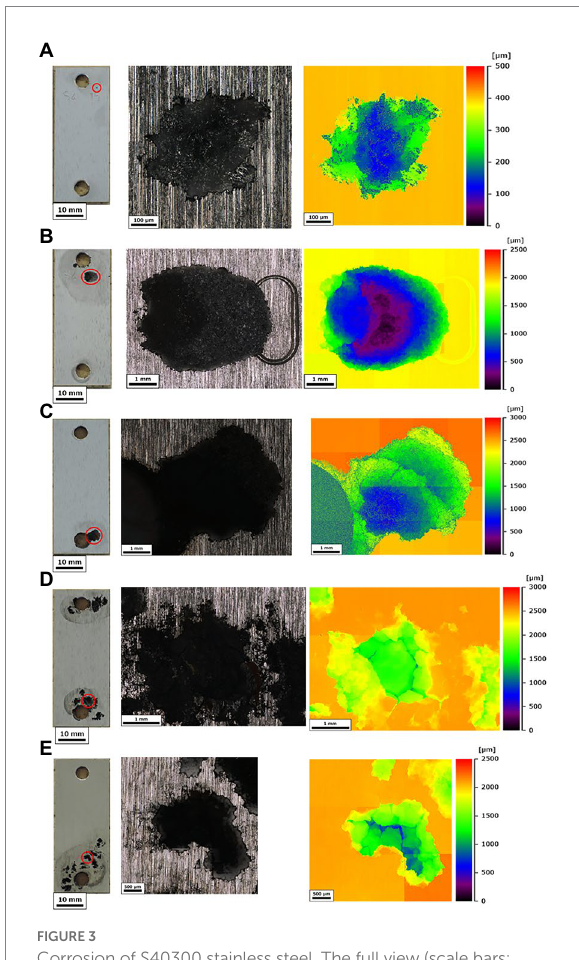
FIGURE 3 Corrosion of S40300 stainless steel. The full view (scale bars: 10 mm) and localized corrosions with maximal depths were visualized using 3D measuring laser microscopy at 1 month (A) 3 months (B) 6 months (C) 14 months (D) and 22 months (E) . The red circles in the full views indicate the measured localized corrosions; mo: